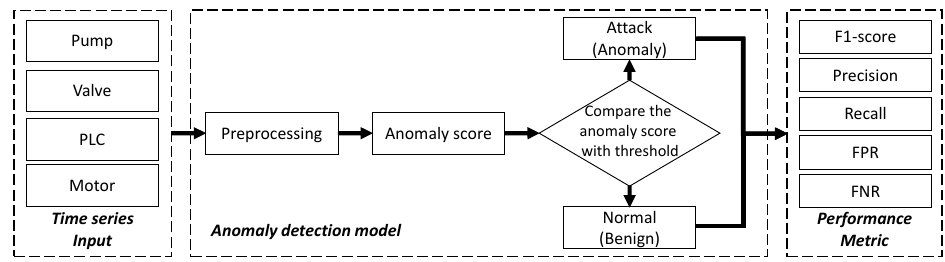
Figure 2. Typical anomaly detection framework using machine learning models in